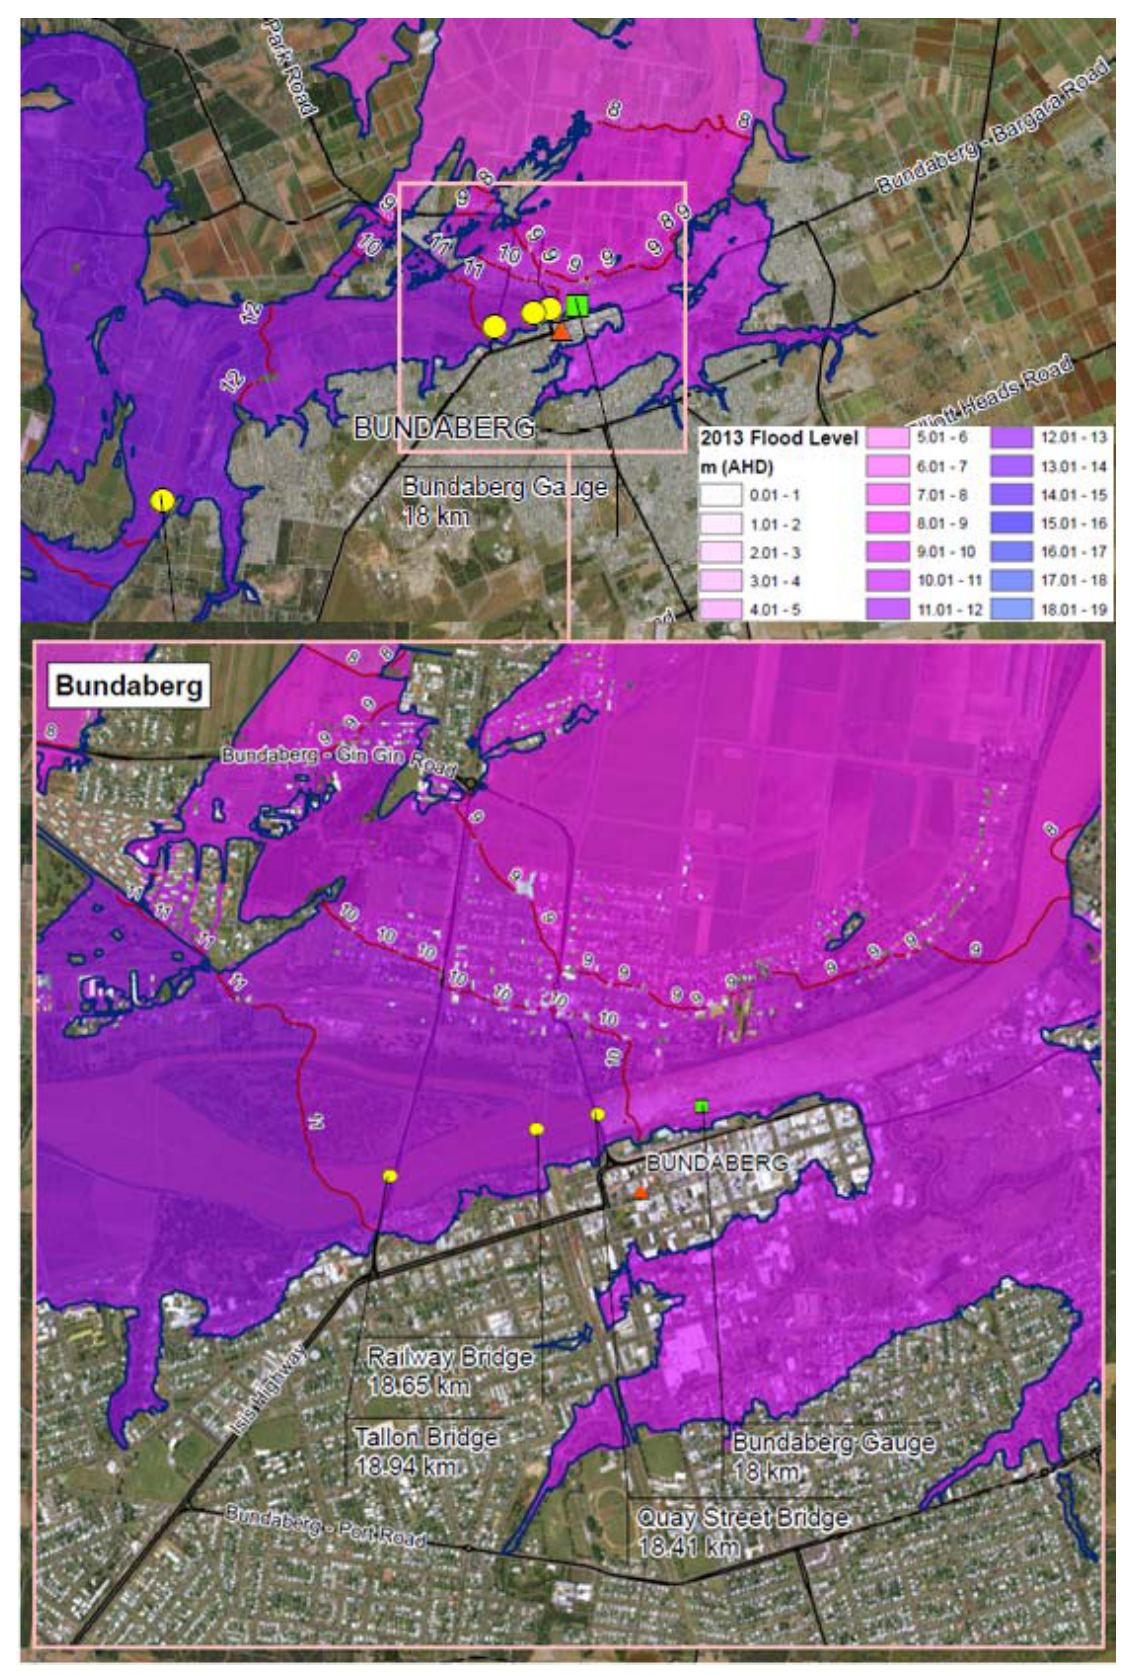
Figure 4. Inundation map of 2013 flood [48].